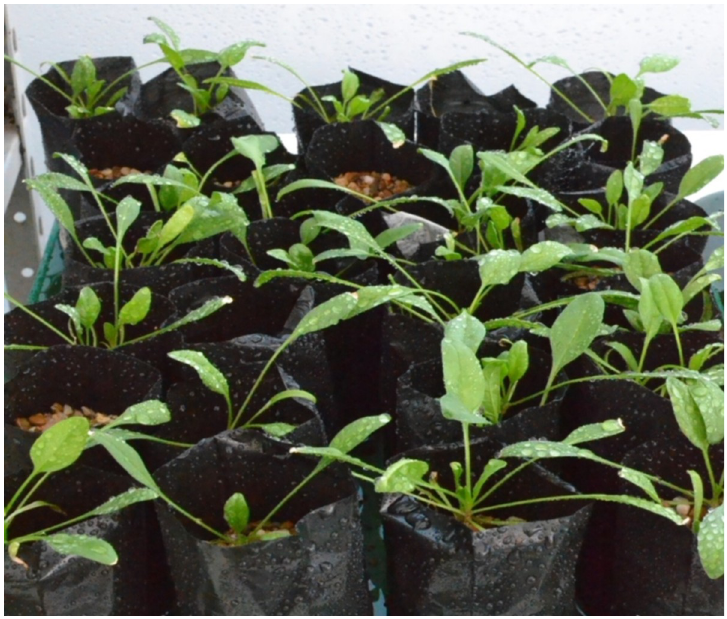
Fig 1. Image of the spinach plants treated with the Ag-TiO 2 NPs suspension of 7.3 nm and 0.25% concentration, under greenhouse condition.